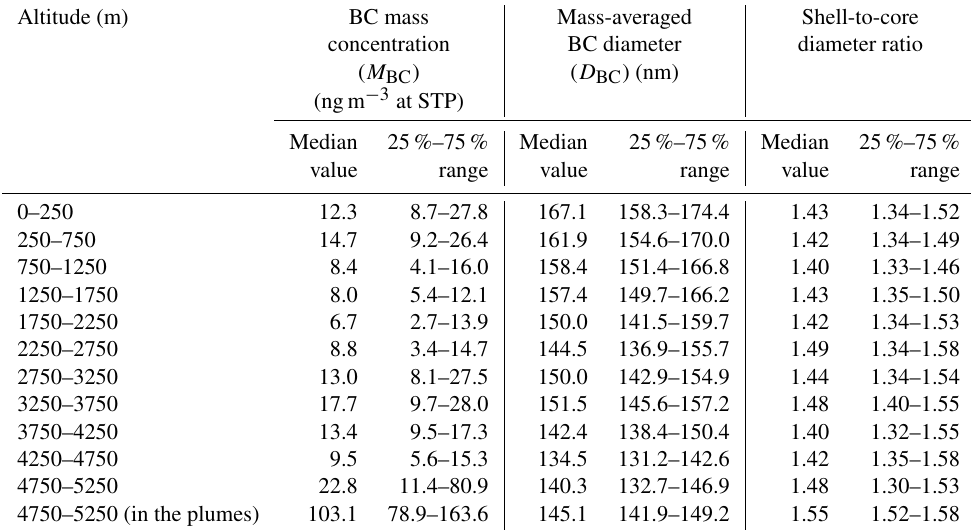
Table 2. Vertical profiles of BC observed during the PAMARCMiP experiment. The 1min data were used for these statistics. The plume data were defined as those with M BC > 50ngm − 3 at STP.